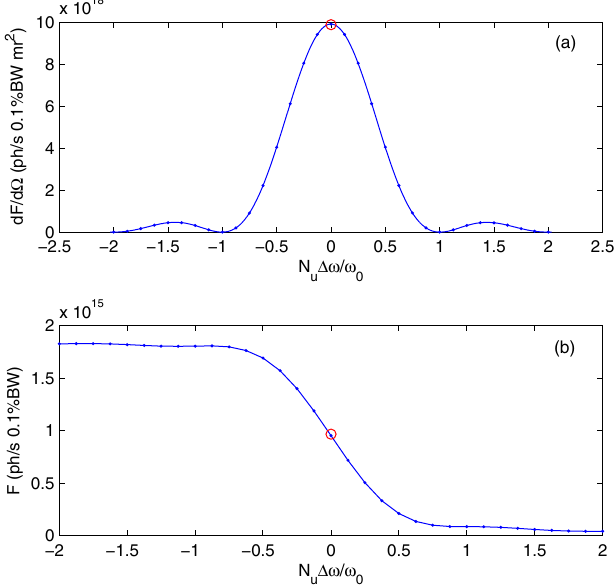
FIG. 15. Scanning around the 1st harmonic resonance of 8 keV for ¼ 250 period planar undulator: (a) angular flux on axis, N u